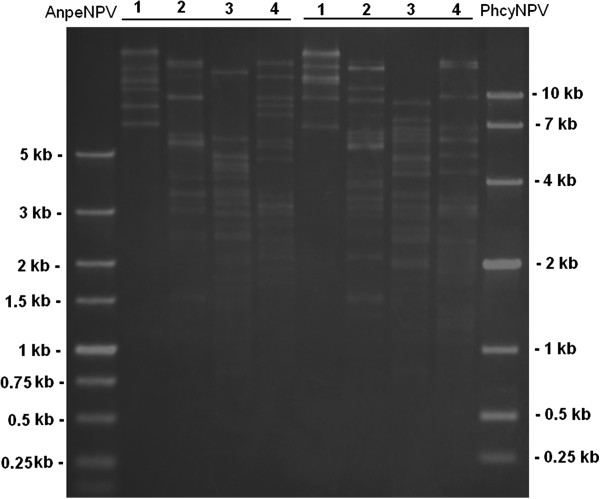
Viral DNAs of Philosamia cynthia nucleopolyhedrovirus (PhcyNPV) and Antheraea pernyi NPV (AnpeNPV) digested with restriction endonucleases. 1, EcoR I; 2, Hind III; 3, Pst I; 4, Sal I.